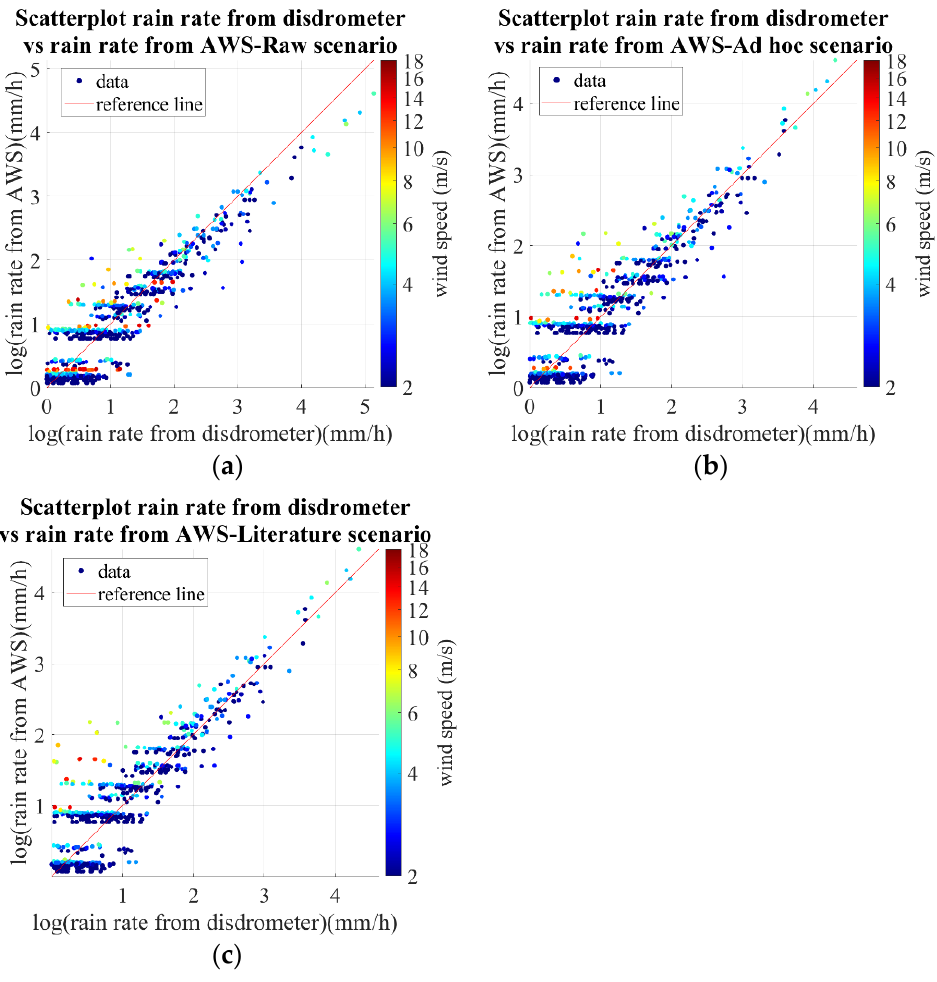
Figure 5. Scatter diagram between 10-min RR measurements (mm h − 1 ) collected by Thies disdrometer (raw data ( a ), ad hoc data ( b ) and literature data ( c )) and FAK010AA rain gauge in the analyzed period. In each panel, the reference line is highlighted in red. The average wind speed (m s − 1 ) measured by the AWS is color-coded according to the vertical bar. Table 2. Rain gauge vs. disdrometer error statistical indicators of rain rate in terms of error percentage (E), mean absolute error (MAE) and the root mean square error (RMSE), as defined by Equations (8), (6) and (9), respectively. The mean and standard deviation (Std) are listed for all scenarios. These results refer to the whole